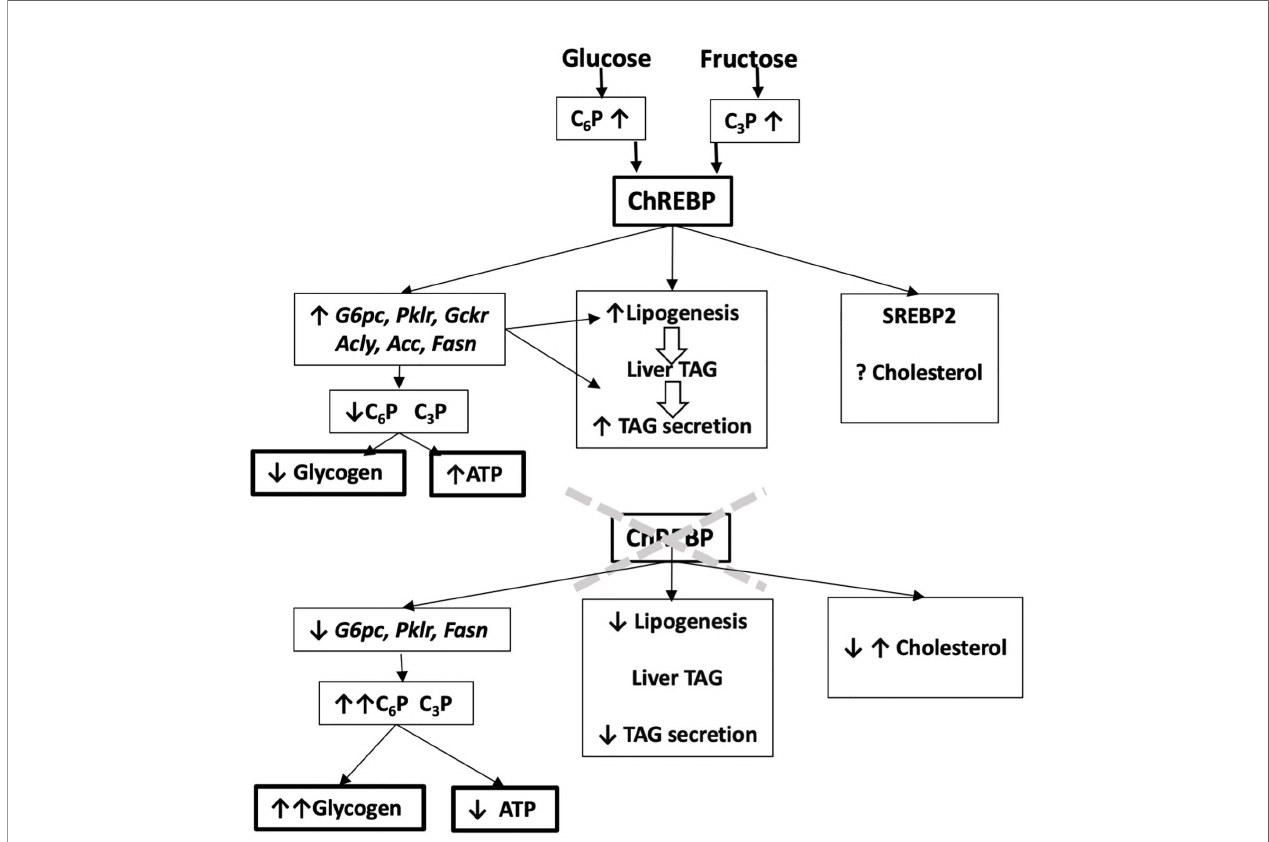
FIGURE 2 | Predicting ChREBP function in liver from ChREBP-knock down models. Liver-selective or global ChREBP deletion mouse models have attenuated mRNA levels of ChREBP target genes, raised hexose phosphate (C 6 P) and triose phosphate (C 3 P) esters, increased glycogen storage and decreased lipogenesis and hepatic triglyceride secretion. They also have impaired hepatic ATP homeostasis. This predicts a role for ChREBP in protecting from liver damage by carbohydrate overload through induction of ChREBP target genes and attenuated glycogen storage and improved phosphate ester and ATP